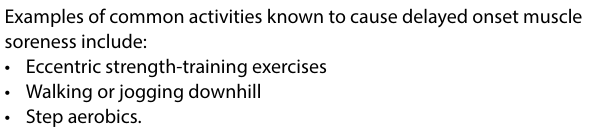
Examples of common activities known to cause delayed onset